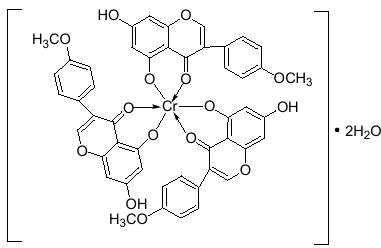
Figure 5. The structure of [CrBCA 3 ].